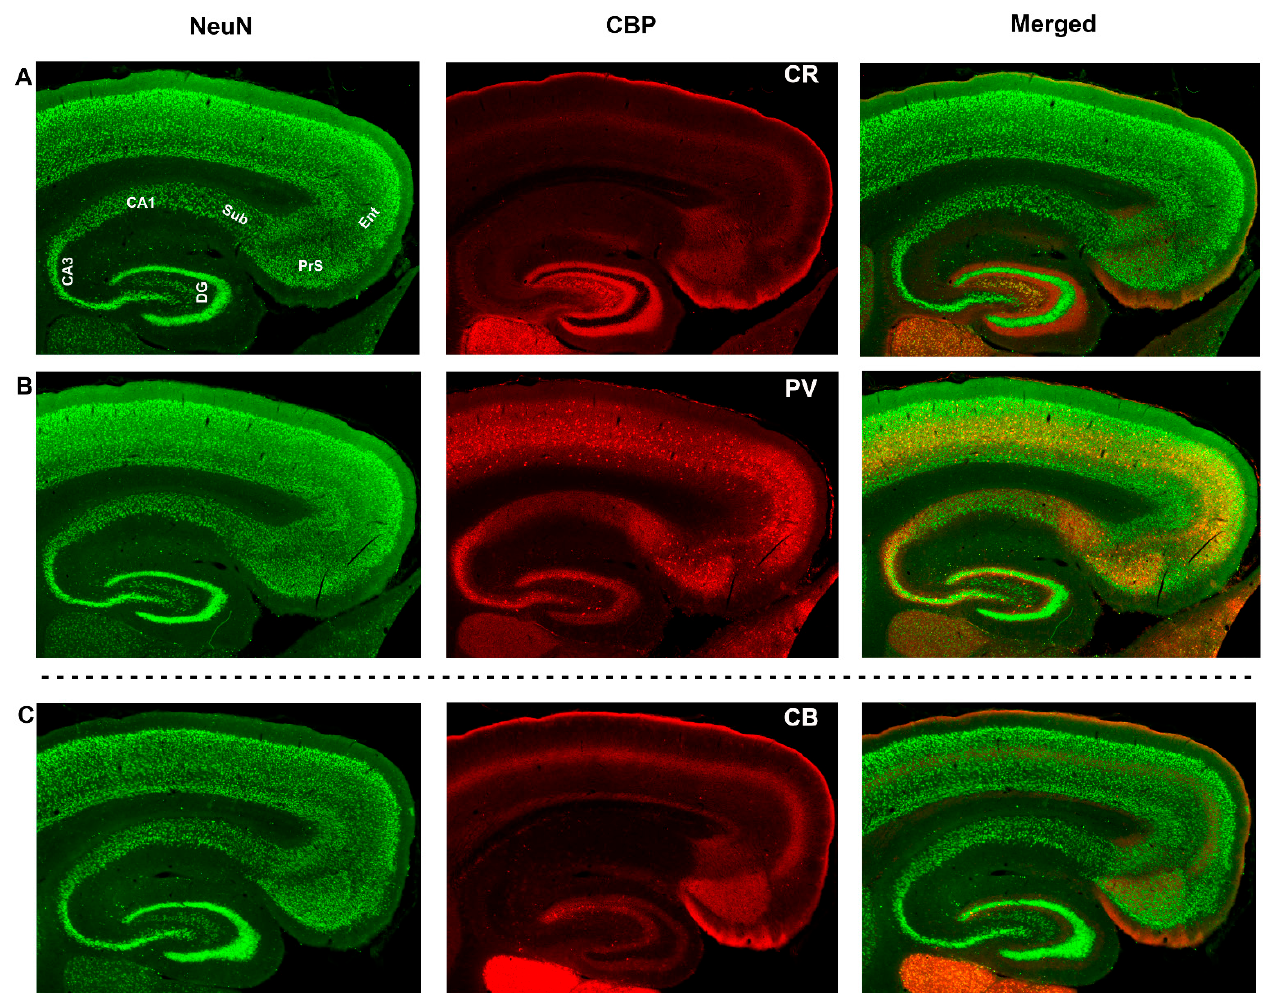
Figure 1. Hippocampal formation in the brain of Carollia perspicillata labeled with NeuN, calretinin, parvalbumin, and calbindin. Widefield images of sagittal sections of Carollia brain showing three pairs of labeling (by row) with NeuN and a calcium binding protein (CBP). Top row ( A ): NeuN with calretinin. Subregional labels are indicated on the NeuN only section (top left). Calretinin labeling alone is shown in the top center (CBP/CR) and the merged image is shown at the top right. Middle row ( B ): NeuN and parvalbumin (PV) labeling from the adjacent section. Bottom row ( C ): NeuN and calbindin (CB) labeling from a near-adjacent section from the same brain. Dotted-line separator indicates that the bottom row is not adjacent to the middle row. The distributions of the calcium binding proteins help to delineate regions and to highlight differences in the distributions of inhibitory neurons and processes. Additional abbreviations: DG—dentate gyrus, CA3— part of regio inferior of cornu Ammonis, CA1—regio superior of cornu Ammonis, Sub—subiculum, PrS—presubiculum, Ent—entorhinal